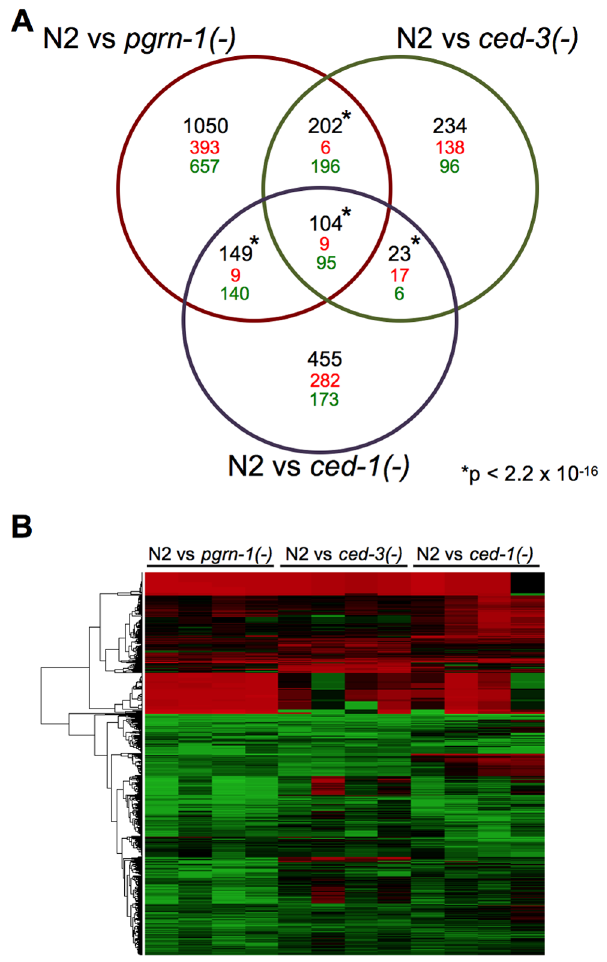
Figure 5. Programmed cell death mutants share differentially regulated genes. (A) Venn diagram of differentially regulated genes in day 1 adult wild-type (N2) animals versus pgrn-1(tm985) , ced-3(n717) or ced-1(e1735) mutants. Significance cut-off was an FDR of , 0.05. The numbers in black represent the total number of overlapping genes, with direction of change (up-regulated=red, down-regulated=green) indicated below. The significance of the overlaps between the mutant strains was calculated using Fisher’s exact test. See the Excel file (Table S5) for gene list. *p value , 2.2 6 10 2 16 . (B) Heat map depicting the fold changes of gene expression in pgrn-1(tm985), ced-3(n717) and ced- 1(e1735) mutants compared to N2 wild-type animals for each of four biological